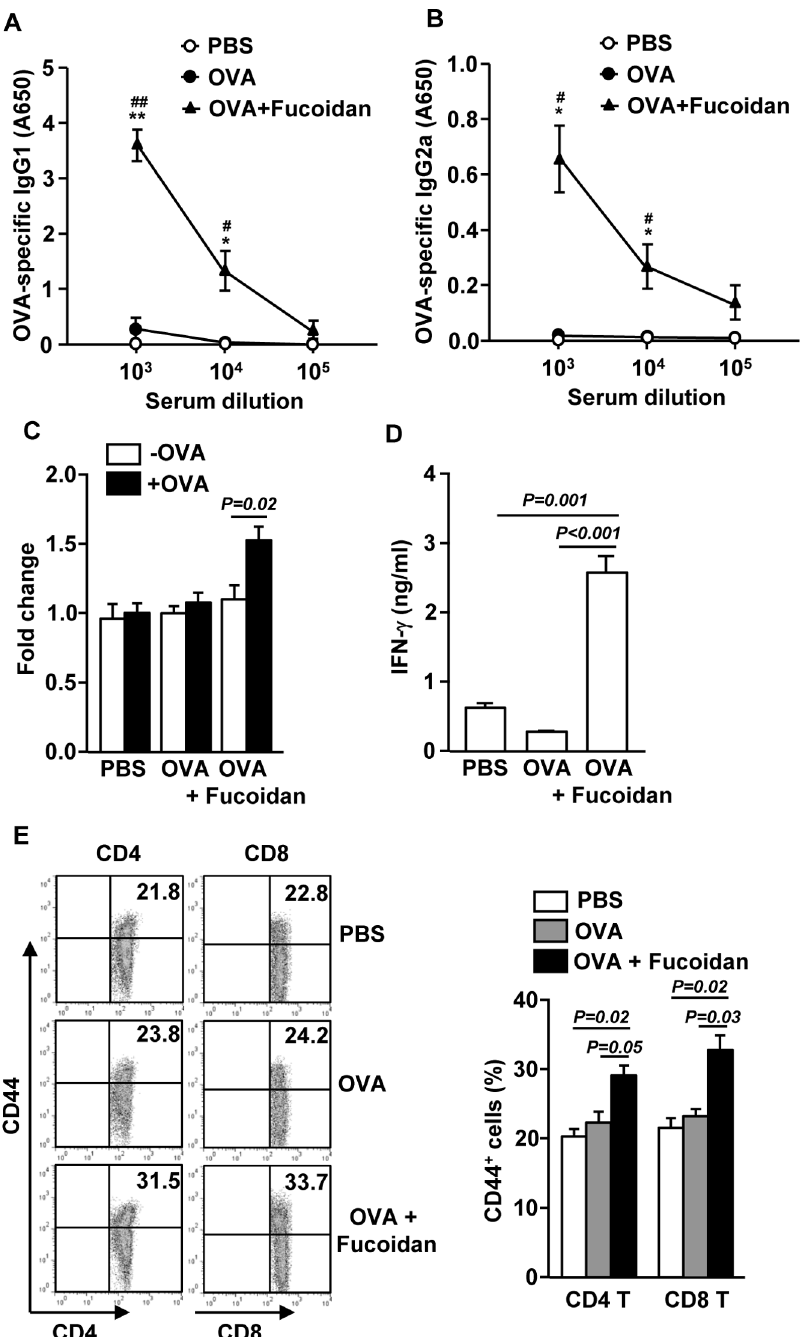
Figure 4. Fucoidan provides an adjuvant effect on OVA-induced B and T cell responses. C57BL/6 mice were immunized i.p with PBS, OVA or OVA + fucoidan on days 0, 15, 30. On day 35, serum OVA-specific IgG1 (A) and IgG2a (B) concentrations were measured by ELISA. * P , 0.05 , ** P , 0.01 versus OVA group. # P , 0.05 , ## P , 0.01 versus PBS group. (C) Splenocytes were harvested from immunized mice on day 35, and re-stimulated with or without OVA (50 m g/ml) for 4 days. Cell proliferation from re-stimulated splenocytes was measured. (D) IFN- c concentrations in the above splenocytes culture supernatants were shown. (E) CD44 expression on CD4 or CD8 T cells was analyzed on a flow cytometer (left panel). Percentage of CD44 + cells in CD4 or CD8 T cells was shown (right panel). All data are representative of 6 samples from 3 independent